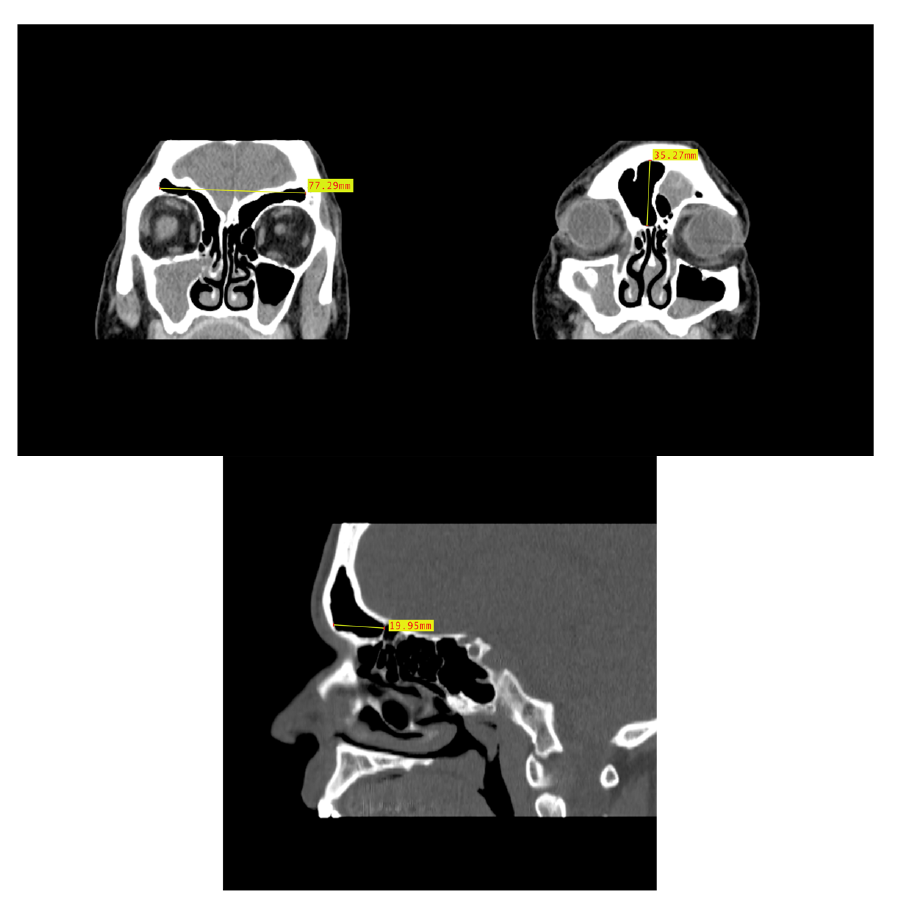
Figure 5. Example of CT image slice showing the maximum height ( left ) and width ( right ) measurement of the frontal sinus in the coronal plane and the frontal sinus maximum depth ( bottom ) in the sagittal plane from three study individuals (yellow lines and red boxes).